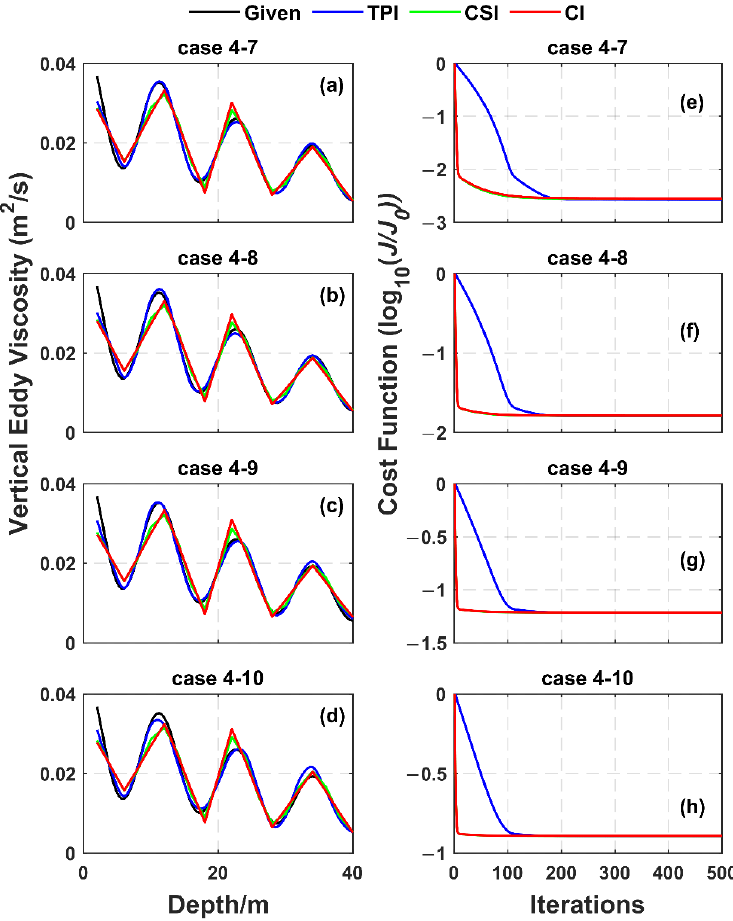
Figure 7. On the left are the prescribed and inverted distributions of the VEVCs after adding 2% ( a ), 5% ( b ), 10% ( c ), and 15% ( d ) errors, respectively. On the right are the cost functions of the three schemes in Group 4. Panels ( a – d ) and ( e – h ) correspond to Cases 4-7, 4-8, 4-9, and 4-10, respectively.